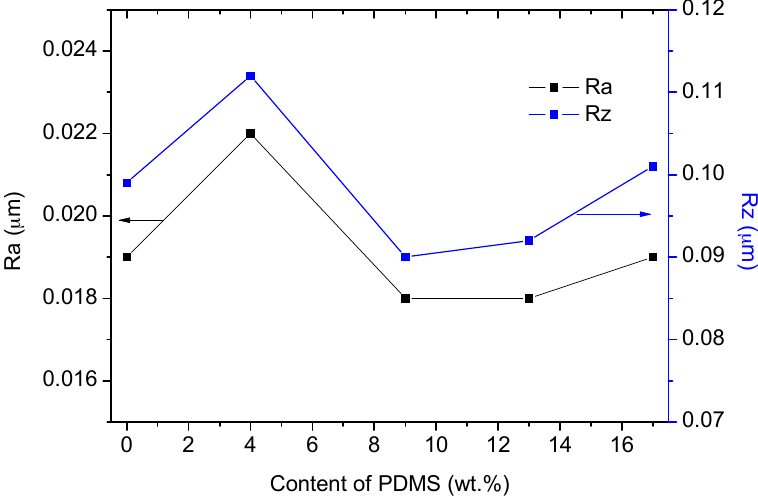
Figure 5. Surface roughness of the PU-Sis samples as determined by CLSM.